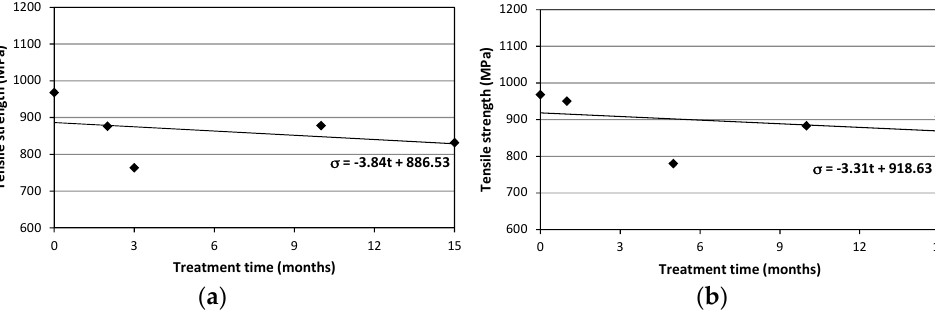
Figure 14. Tensile strength vs. treatment time for SC-series: ( a ) NaCl solution; ( b ) deionized water.